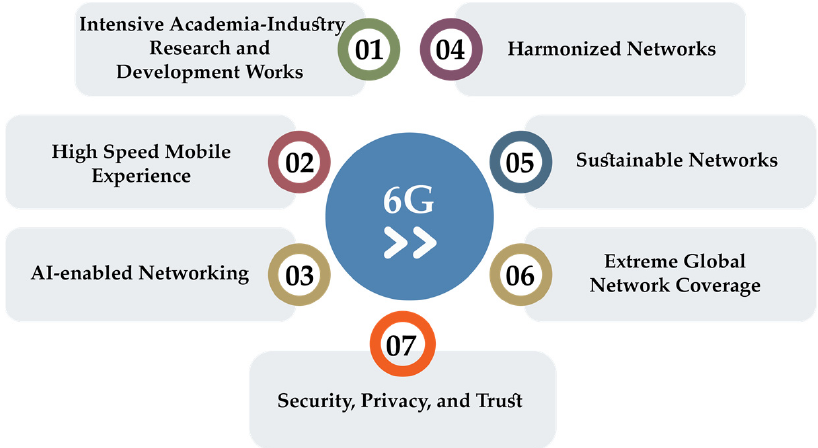
Figure 12. Future trends and directions in 6G technology